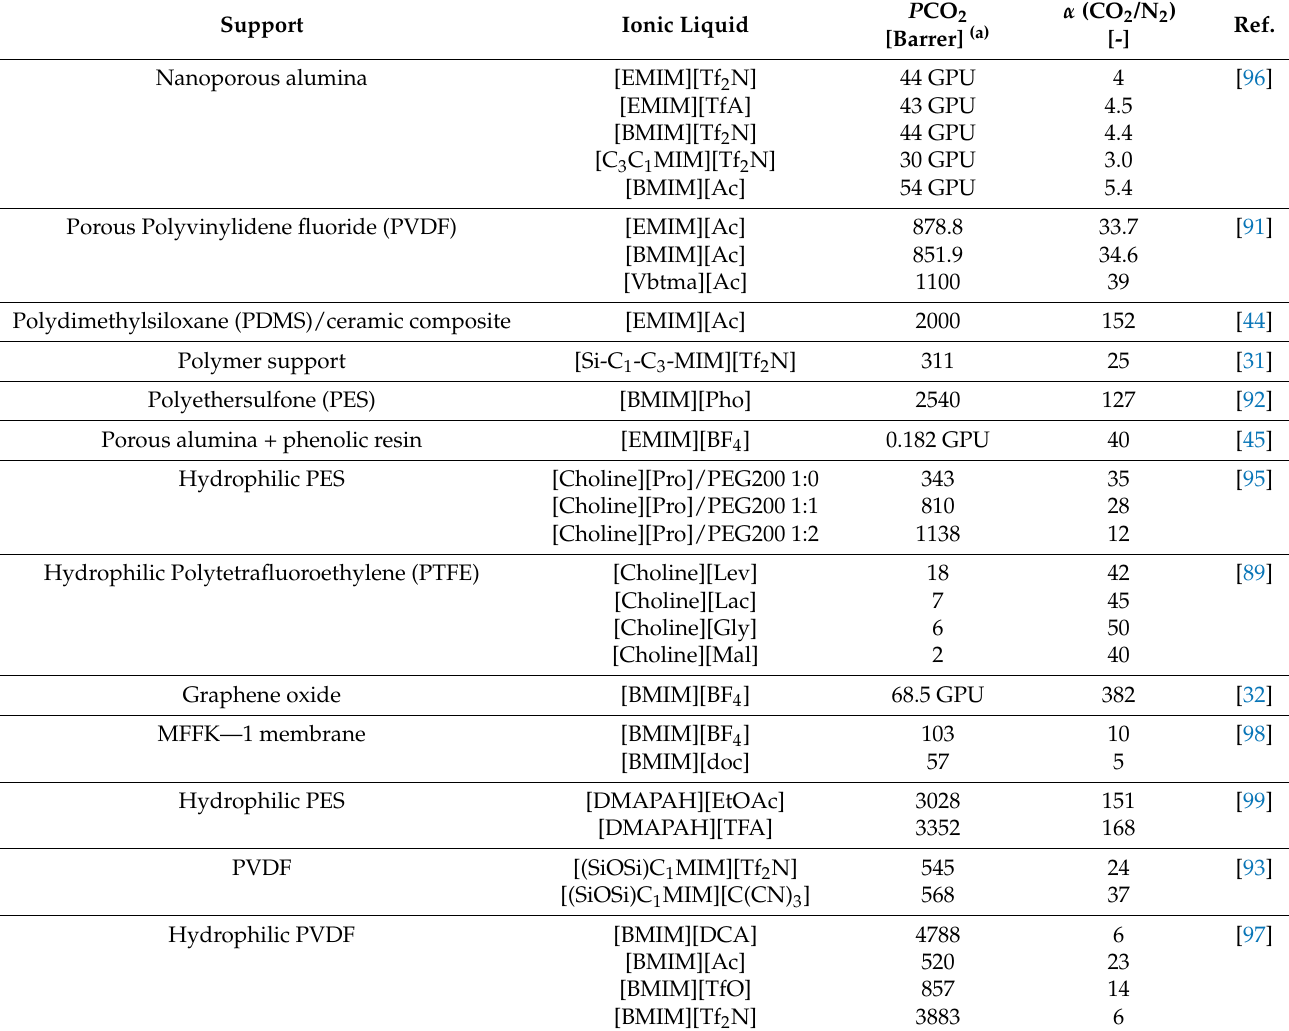
Table 1. Some recent data for supported ionic liquid membranes in CO 2 /N 2 separations.